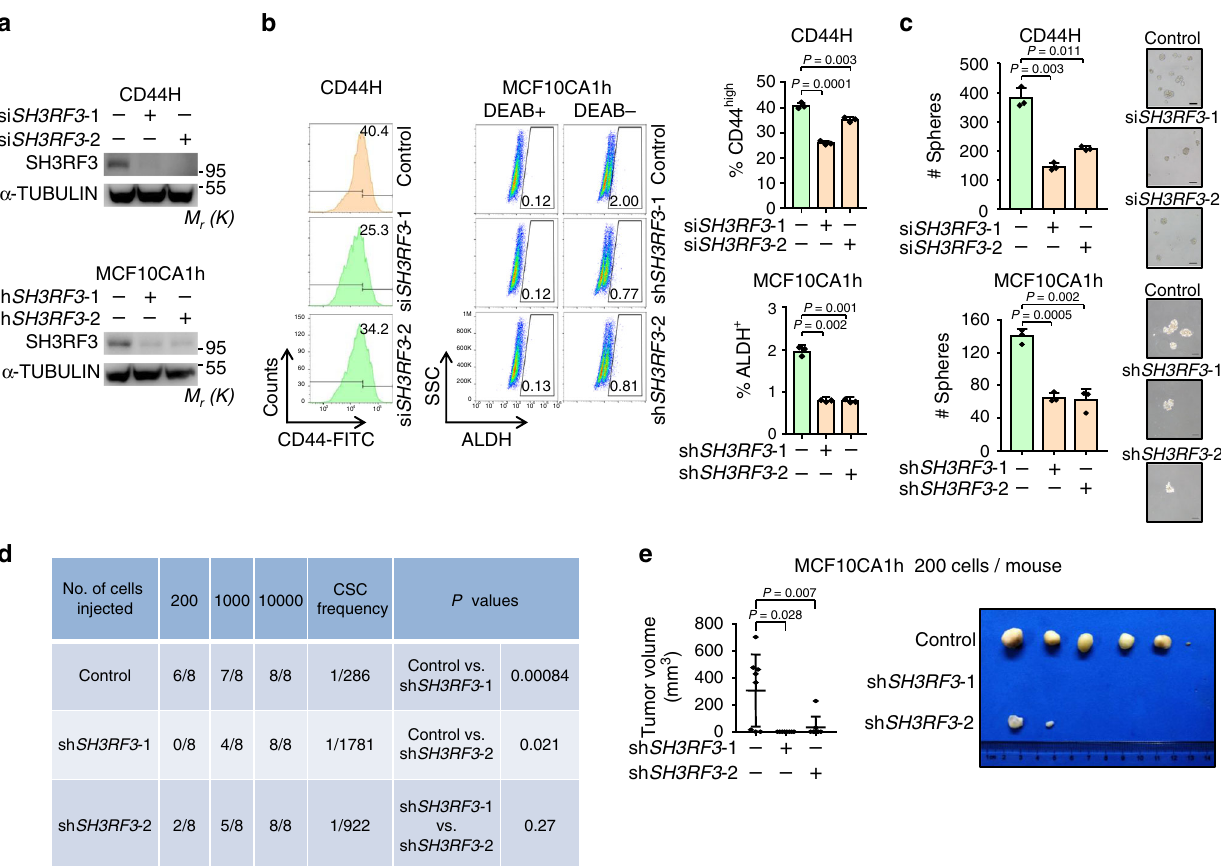
Fig. 3 SH3RF3 knockdown impairs CSC traits of breast cancer cells. a SH3RF3 knockdown in HMLER-CD44H and MCF10CA1h cells. b Flow cytometry analyses of the CD44 high subpopulation in HMLER-CD44H and the ALDH + subpopulation in MCF10CA1h ( n = 3 cell culture experiments). c Quantitation and representative images of tumorsphere formation of breast cancer cells with SH3RF3 knockdown ( n = 3 sphere culture experiments). Scale bar, 100 μ m. d In vivo tumor formation of the mice injected with serial dilutions of MCF10CA1h at day 42. e Tumor images and volumes ( n = 8 mice) in mice injected with 200 control or SH3RF3 knockdown MCF10CA1h cells. Data represent mean ± SD. Statistical signi fi cance was determined by two-tailed unpaired t -test ( b and c ), chi-squared test ( d ) or Mann – Whitney U-test ( e ). The experiments in ( a ), ( b ) (left), and ( c ) were repeated three times independently with similar results, and the data of one representative experiment are shown. Source data are provided as a Source data fi